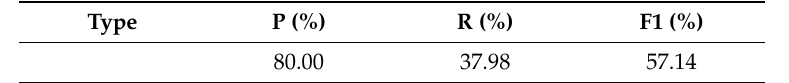
Table 14. Relation extraction performance of the proposed CRF model when using only word features Fwc .